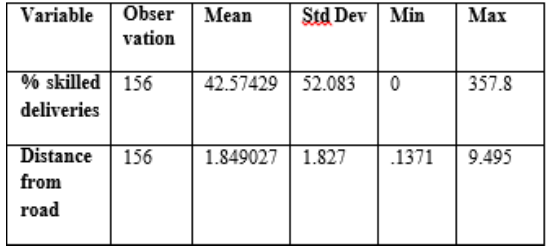
Table 2: STATA Output: Linear regression of distance